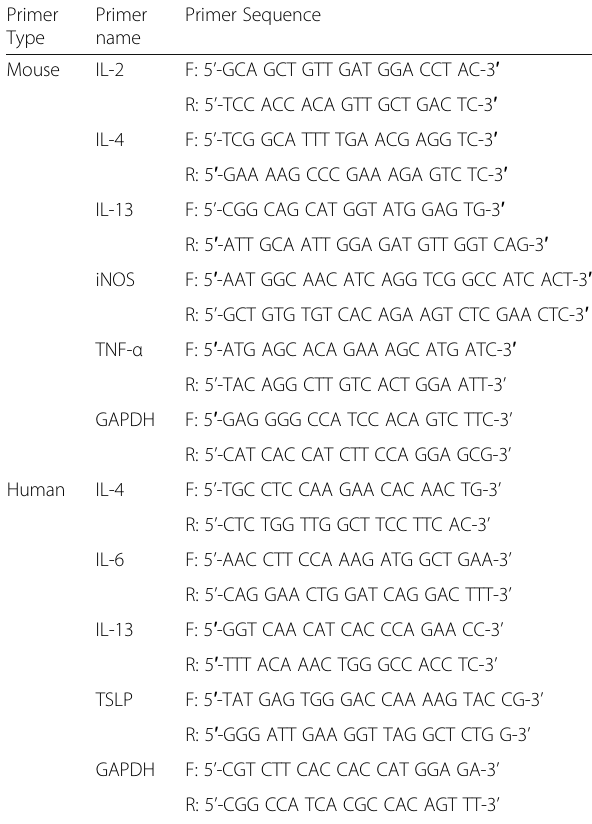
Table 1 PCR primer sequences Primer